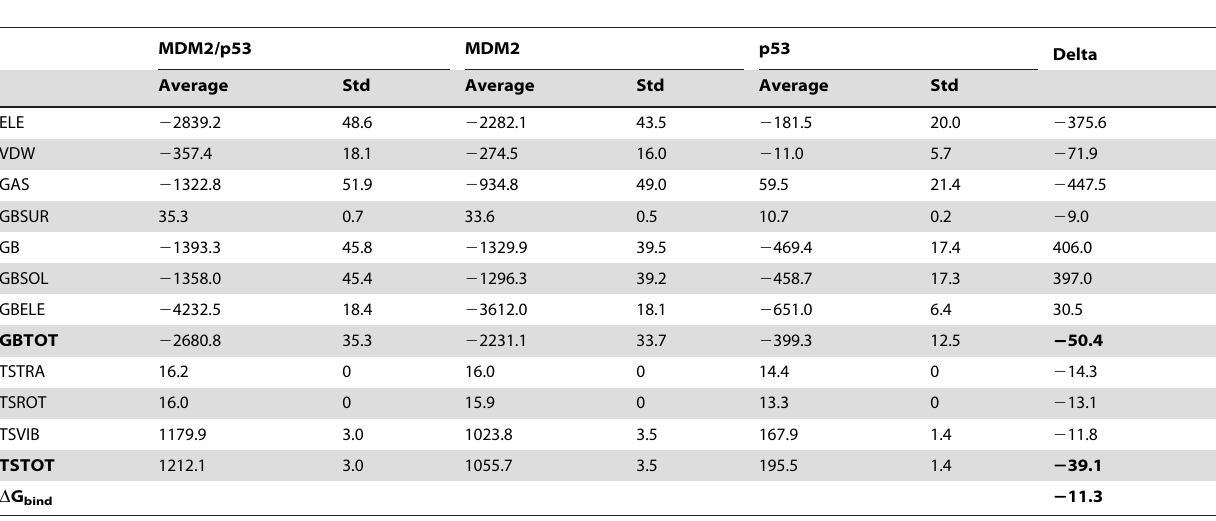
Table 3. Components of binding free energy (in kcal/mol) of MDM2 with p53 peptide.